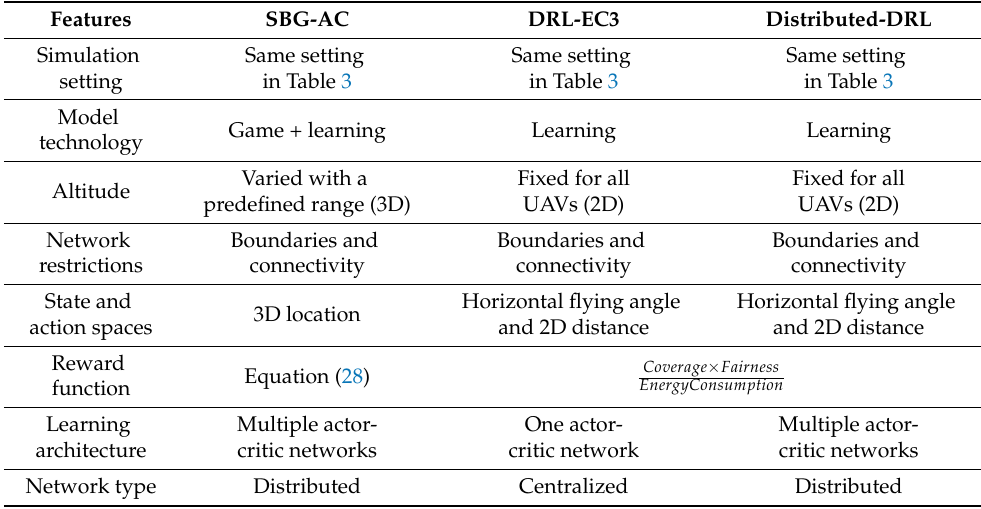
Table 5. Description of the SBG-AC, DRL-EC3, and distributed-DRL models.